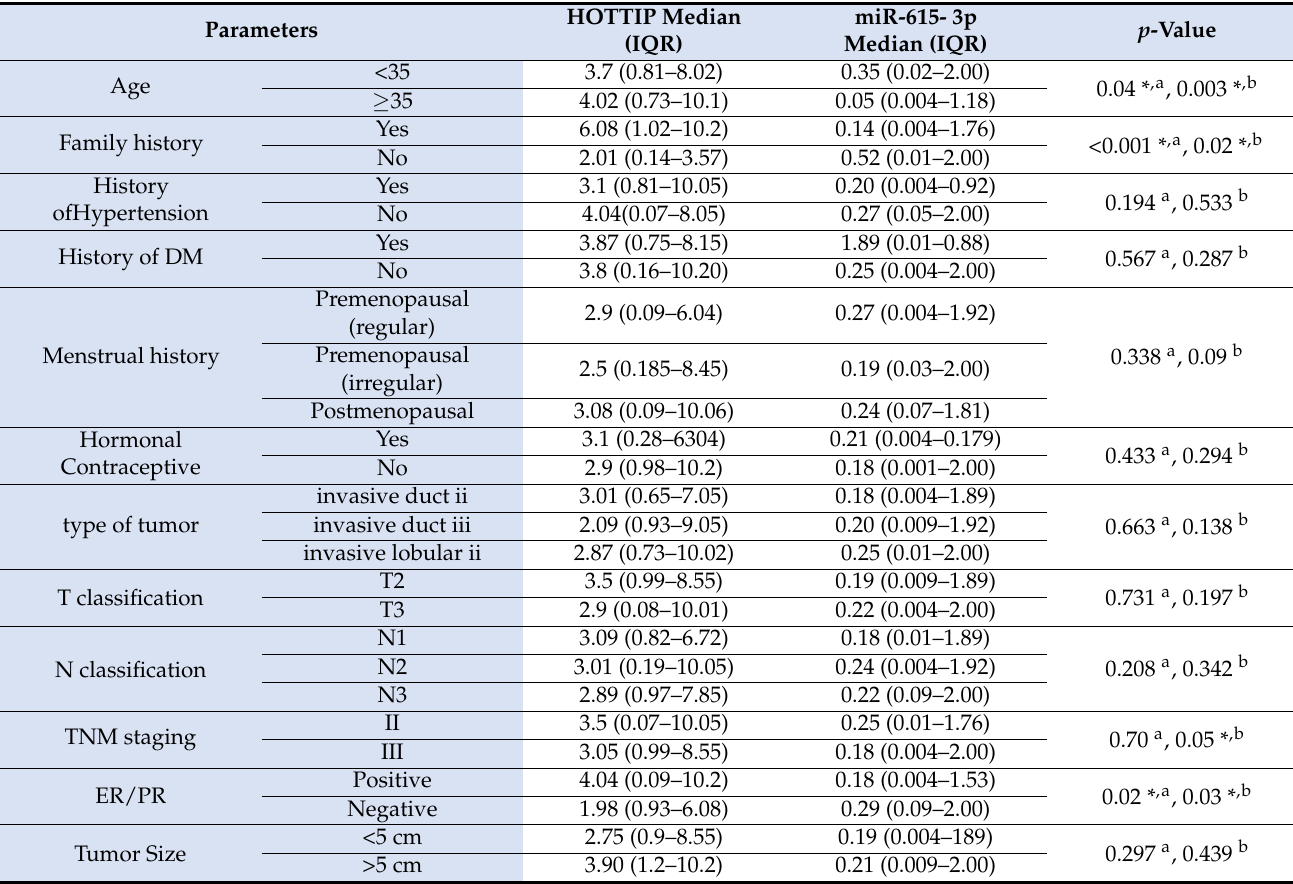
Table 4. Differences in the HOTTIP and miR-615-3p serum expression levels in relation to the clinical and pathological features in BC